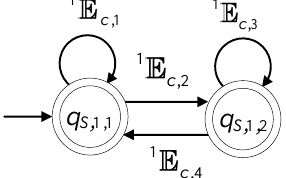
Figure 8. State diagram of S 1